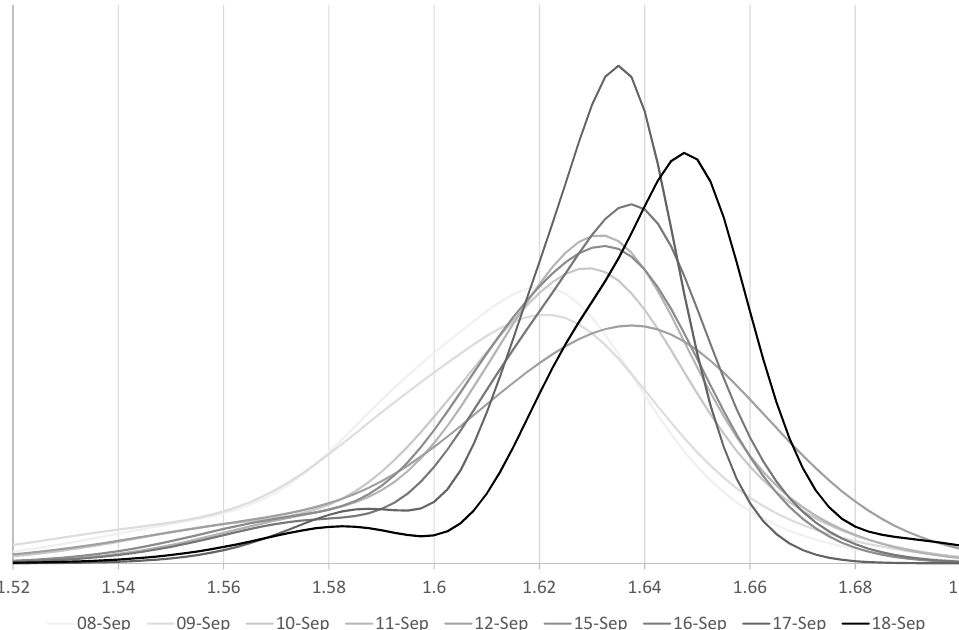
Figure 10. GBPUSD implied densities for the 2014 Scottish independence referendum date (8 to 18 September